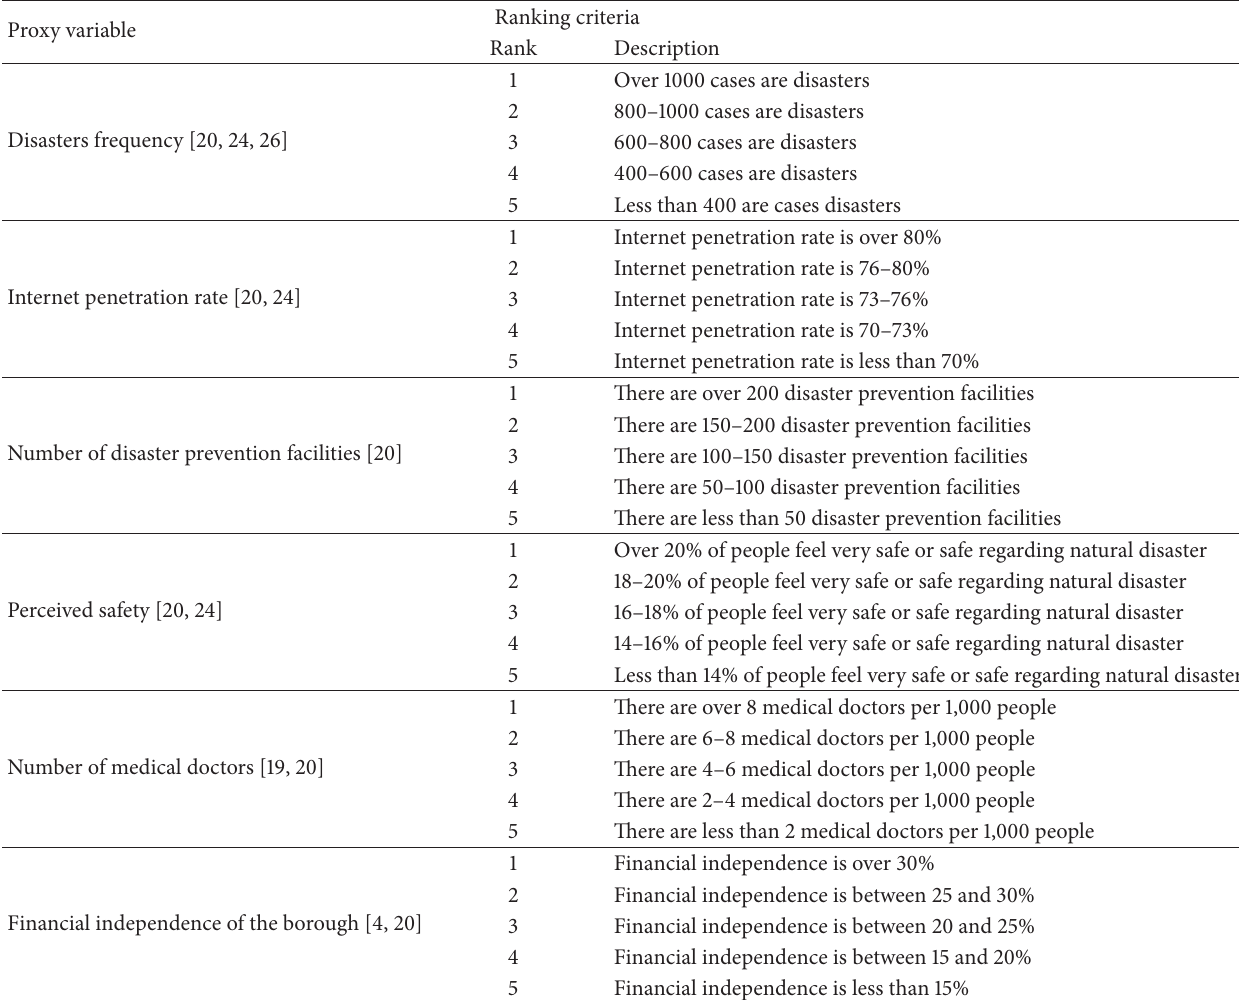
Table 6: Criteria for ranking of proxy variables of